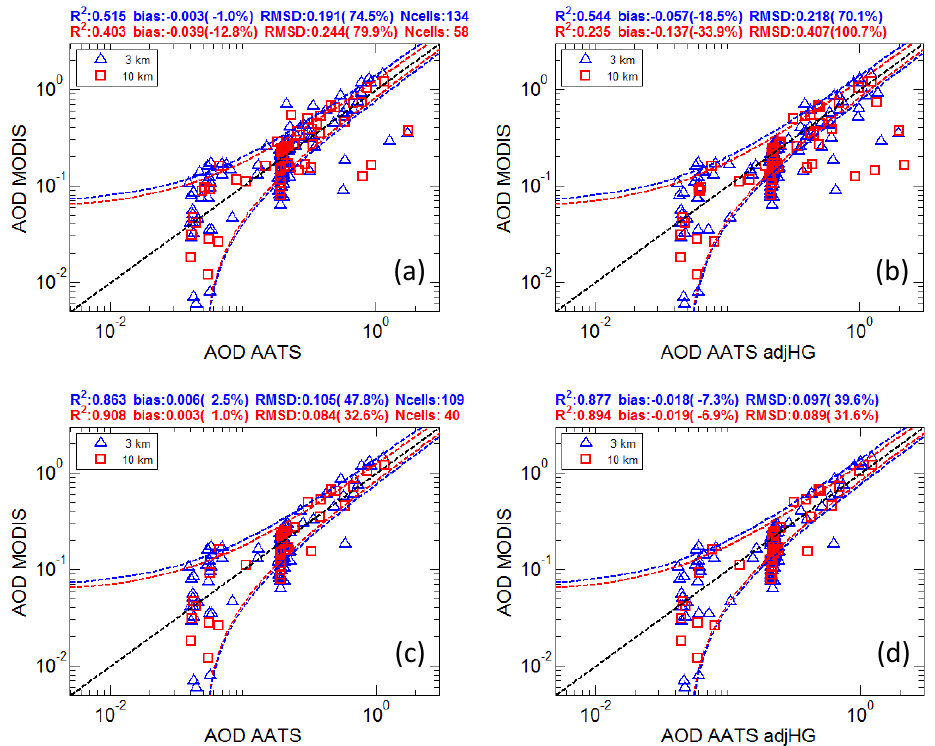
Fig. 13. Scatterplots of MODIS versus AATS AOD for the composite data set. (a, c) Results as a function of AATS AOD without the addition of below-aircraft AOD estimates. (b, d) Results as a function of AATS AOD with the addition of below-aircraft AOD estimates. (a) and (b) include all five cases; panels (c) and (d) omit the 2 July case.